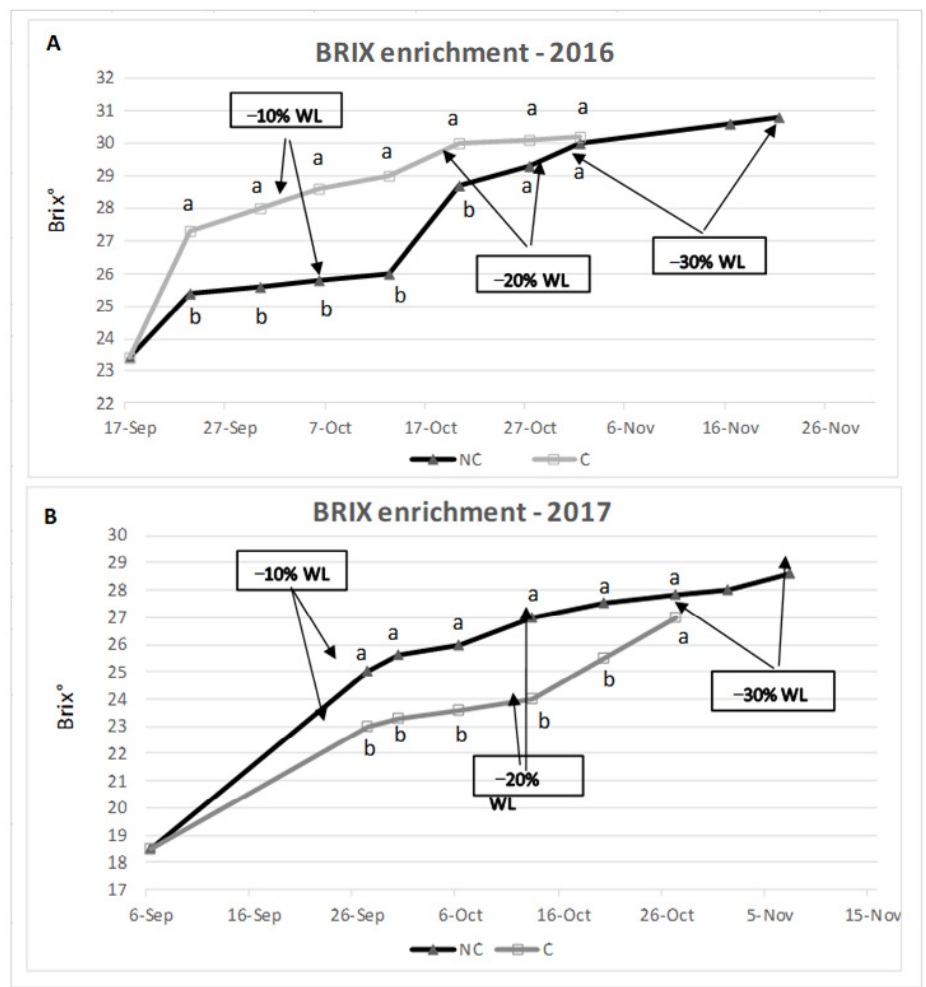
Figure 4. Brix degree enrichment in 2016 ( A ) and 2017 ( B ). Arrows mean different WL values . Where present, values indicated with different letters were significantly different ( p < 0.05) between three analytical replicates.